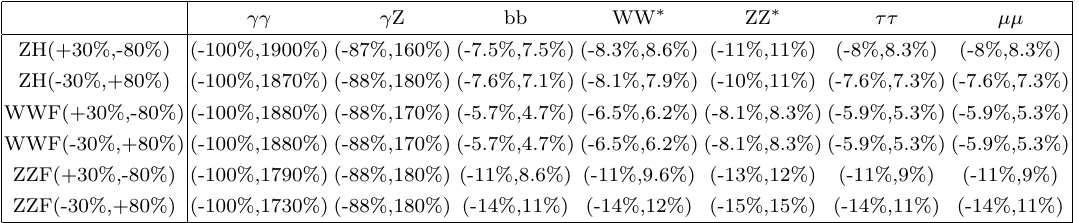
Table 10 . Possible deviations in signal strengths (in percent) caused by top-quark operators, in Higgs production (WWF for WW fusion and ZZF for ZZ fusion) and decay channels, at an e + e (cid:0) collider at 250 GeV centre-of-mass energy. All top-quark operator coe(cid:14)cients are allowed to vary within the current constraints, described in table 8.